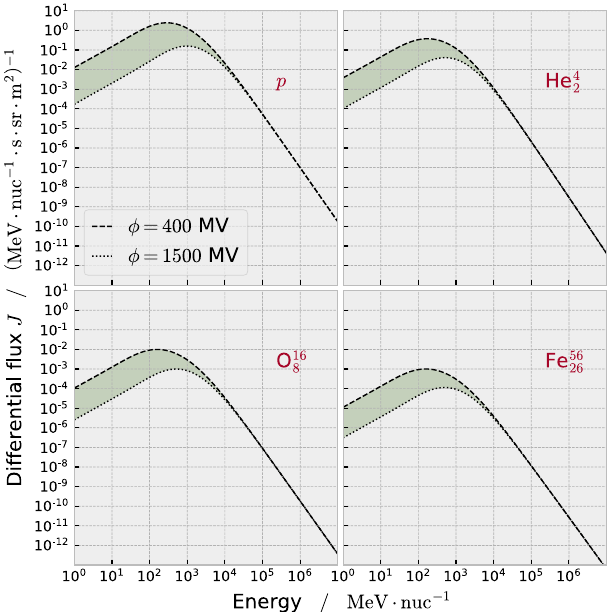
Fig. 3. BON10 spectra of protons (top left), helium nuclei (top right), oxygen nuclei (bottom left) and iron nuclei (bottom right), for two extreme cases of solar activity. During solar maximum (dotted black line, / = 1500 MeV) the fl ux of low energy particles decreases relative to periods of low solar activity (dashed black line), corresponding to a solar modulation parameter / = 400